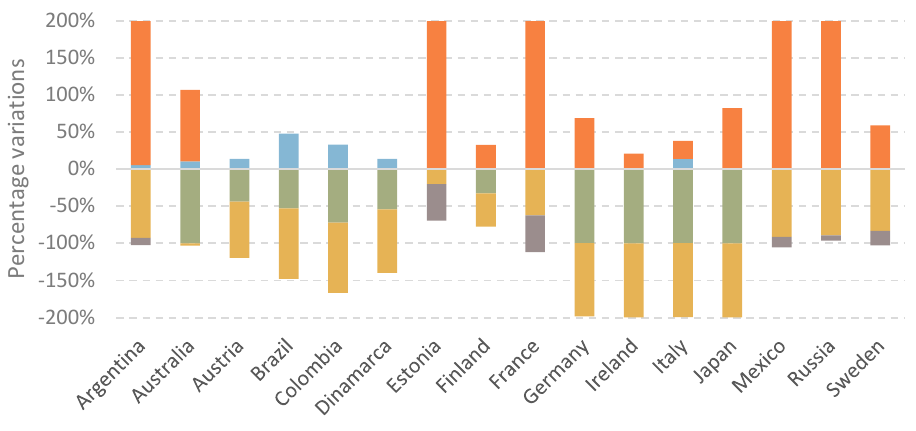
Figure 3. Modifications for reaching the frontier—electricity market. Source: The authors.